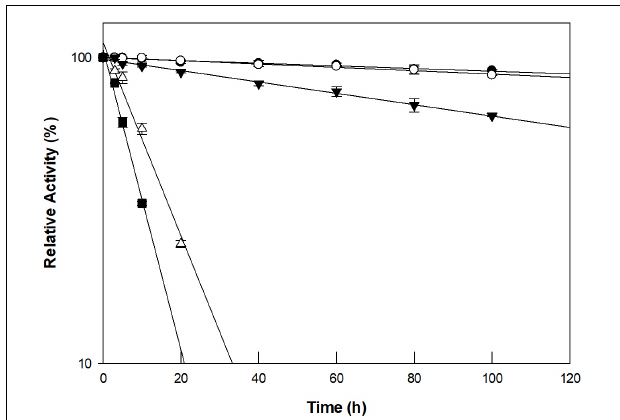
FIGURE 3 | Effect of substrate concentration on D -allose production (closed circles) and conversion yield (open circles) in a packed bed reactor. The reactions were performed in 50 mM EPPS buffer (pH 8.0) containing 100–700 g/L D -allulose at 60 ◦ C at a dilution rate of 0.24/h. Data represent the means of three experiments ± SD.